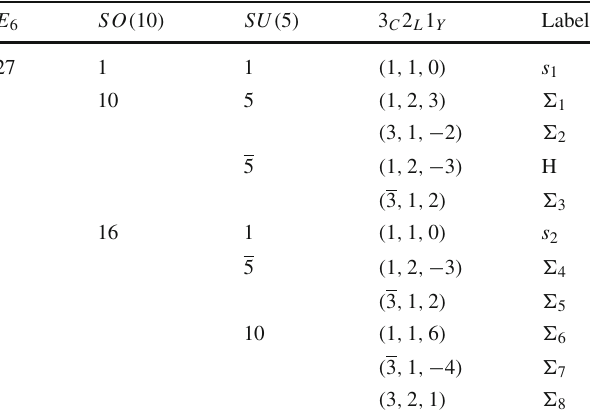
Table 6 Decomposition of the scalar 27-dimensional representation of E 6 with respect to the subgroups SO ( 10 ) , SU ( 5 ) and SU ( 3 ) C × SU ( 2 ) L × U ( 1 ) Y . For further details, see Table 1